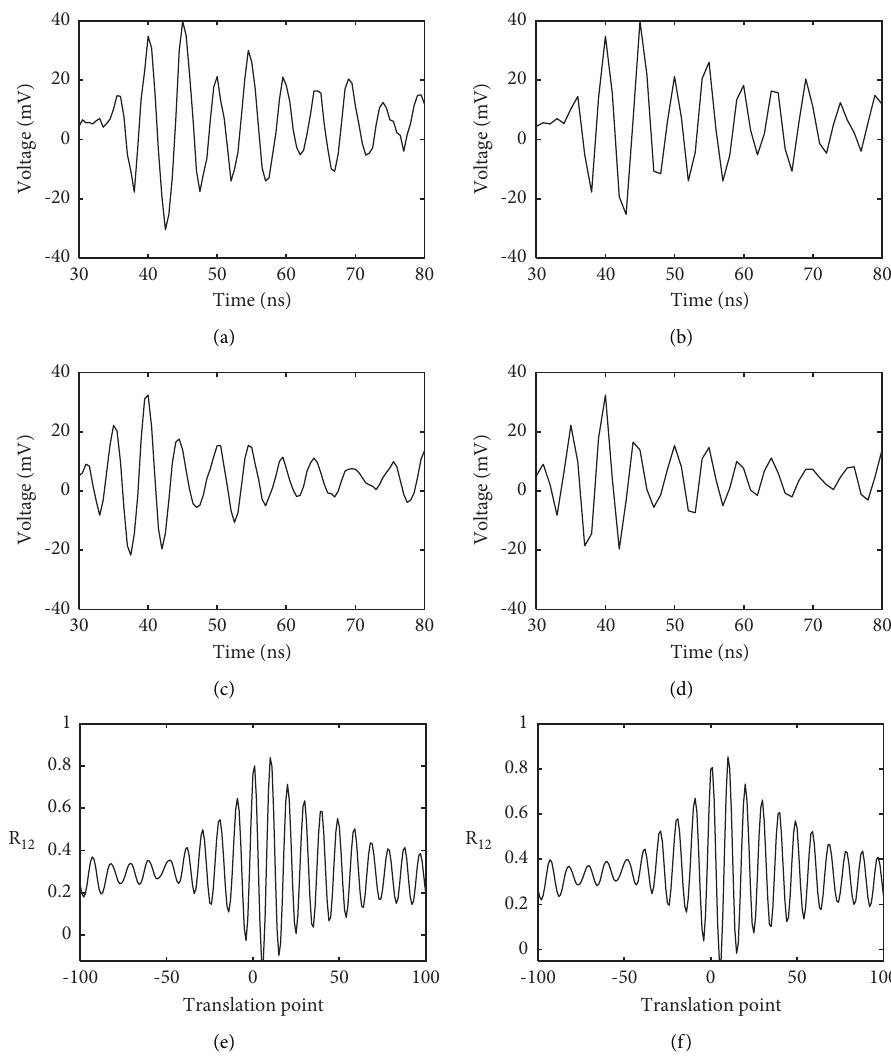
Figure 5: The interpolated 2 GHz PD UHF pulse signals and the correlation coefficient curve. (a) Interpolated antenna A received PD signal by fuzzy interpolation. (b) Interpolated antenna A received PD signal by cubic spline interpolation. (c) Interpolated antenna B received PD signal by fuzzy interpolation. (d) Interpolated antenna B received PD signal by cubic spline interpolation. (e) Correlation coefficient curve for interpolated signals by fuzzy interpolation. (f) Correlation coefficient curve for interpolated signals by cubic spline